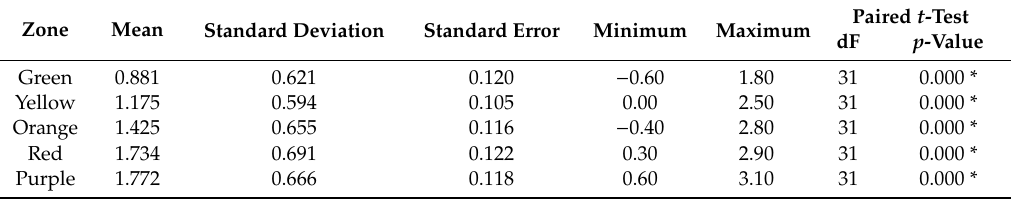
Table 6. Variation of shoulder skin temperature (ºC).